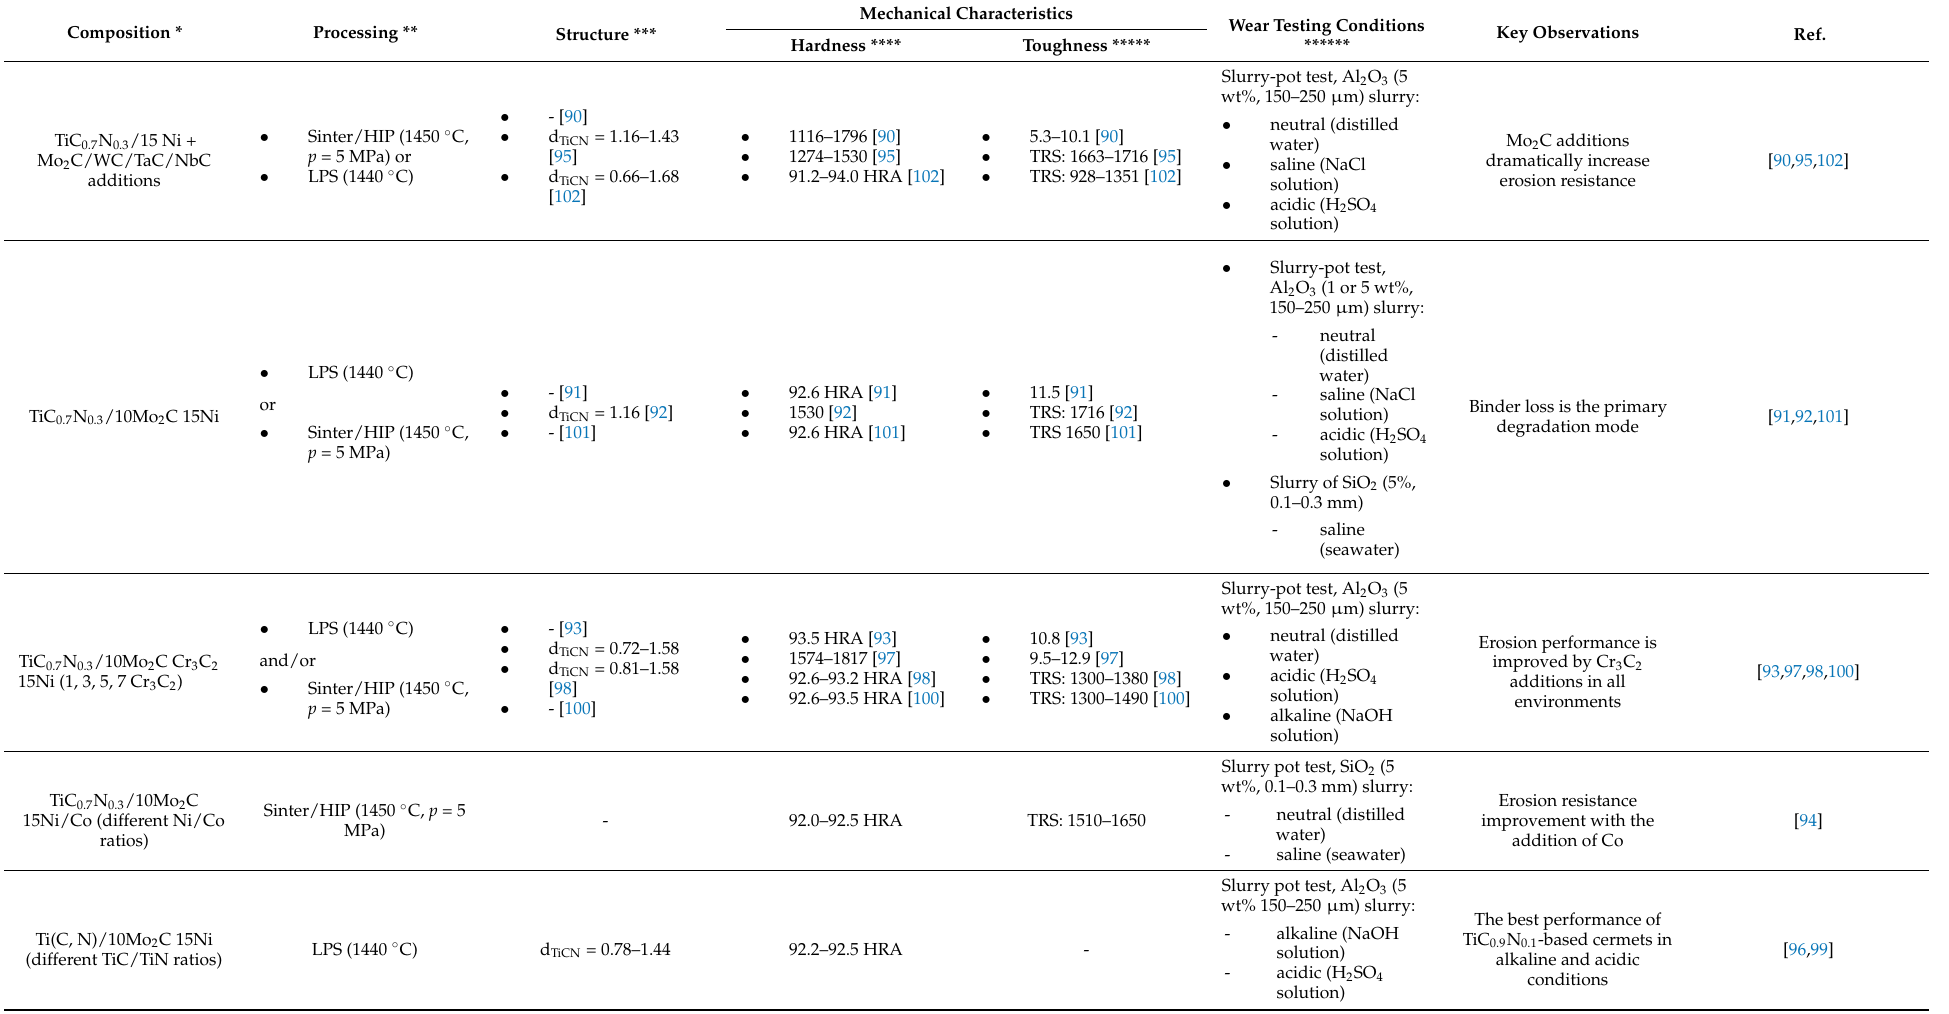
Table 5. Summary of composition, processing, structural and mechanical characteristics and slurry erosion testing conditions of